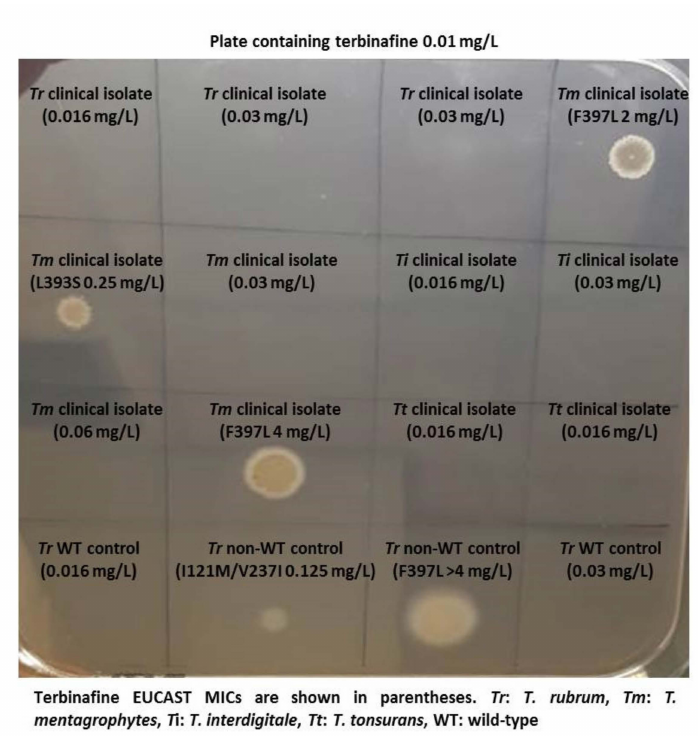
Figure 1. The method successfully discriminated WT from non-WT Trichophyton spp. clini- cal isolates showing 100% agreement with the reference broth microdilution